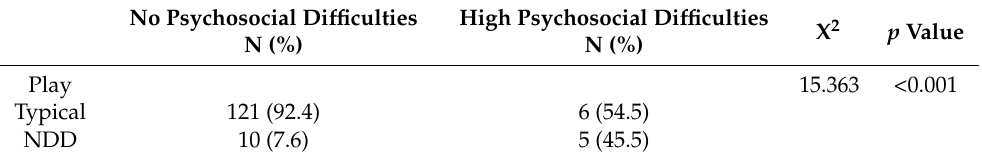
Table 5. Presence of psychosocial difficulties in children with typical and atypical play performance ( n = 142).